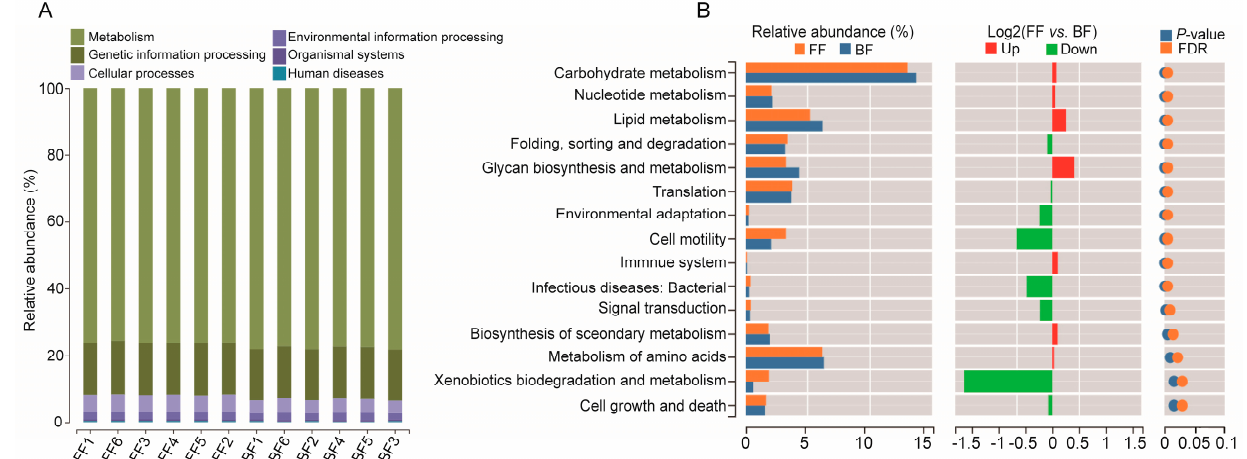
Figure 5. Microbiota functional differences analysis: ( A ) Microbiota function predicted based on the KEGG database (at level I). ( B ) The relative abundance of KEGG metabolic pathways (at level II). Only p < 0.05 is shown for demonstration and clarity.